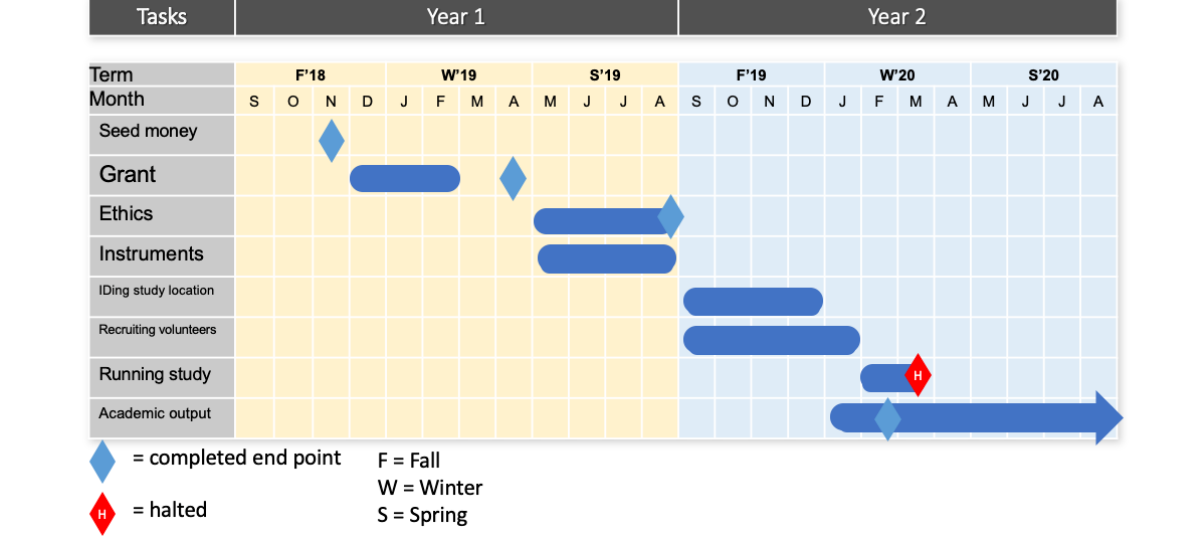
Figure 2. Gantt chart for currently completed pilot.